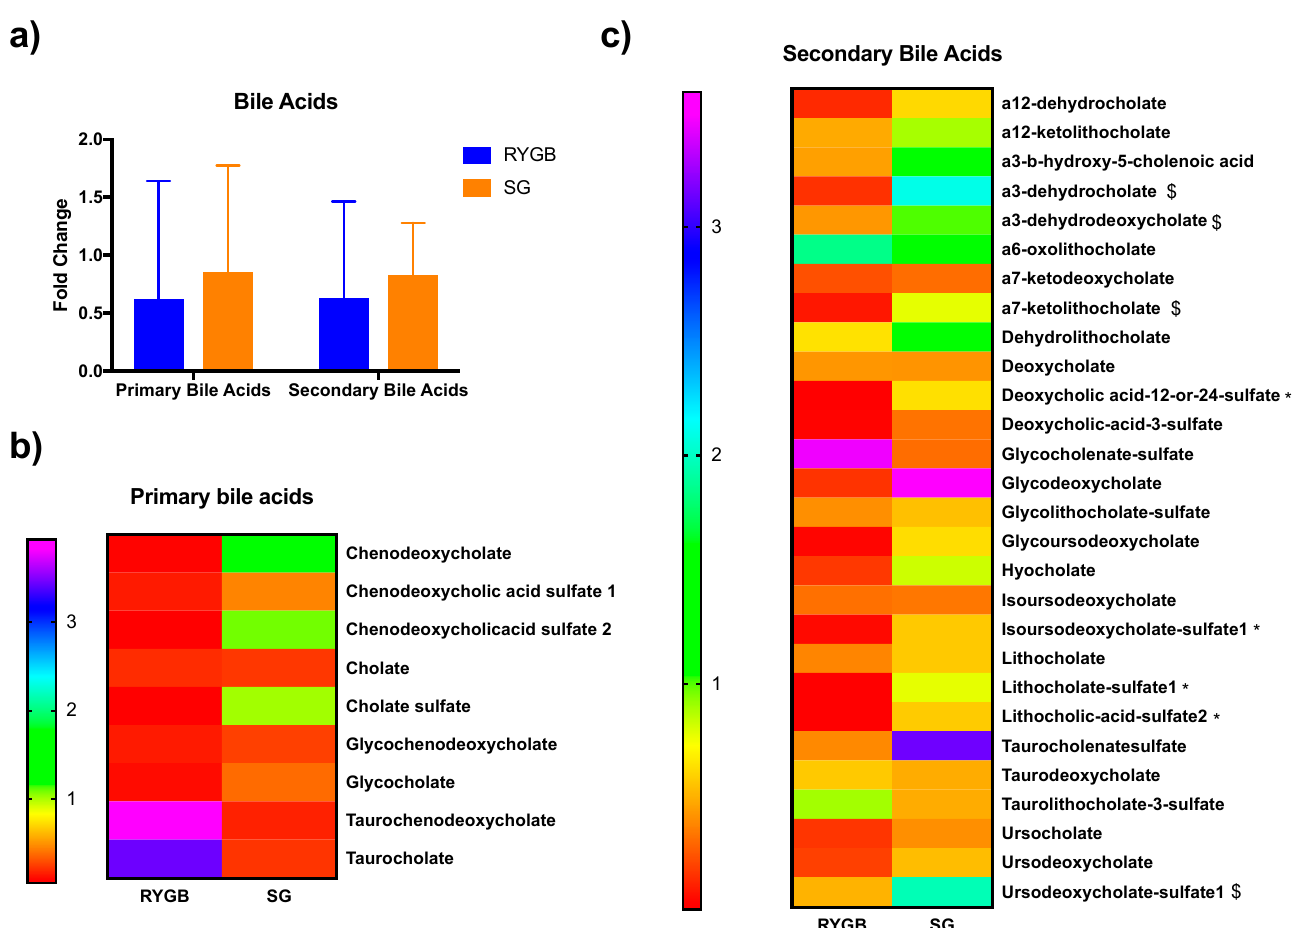
Figure 2. Heatmap of the bile acids fold changes in the two bariatric surgery procedures studies. ( a ) Total bile acids changes. ( b ) Primary bile acids changes. ( c ) Secondary bile acids changes. Changes are shown as fold changes within each procedure; * indicates statistical differences ( p < 0.05) between procedures, $ indicates a statistical tendency ( p < 0.10) between procedures.